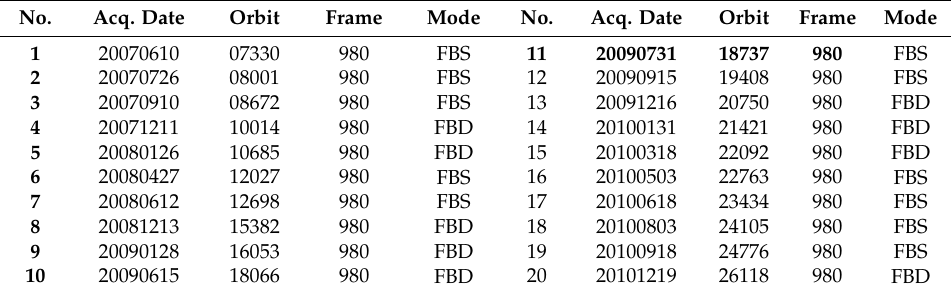
Table 1. Information of data